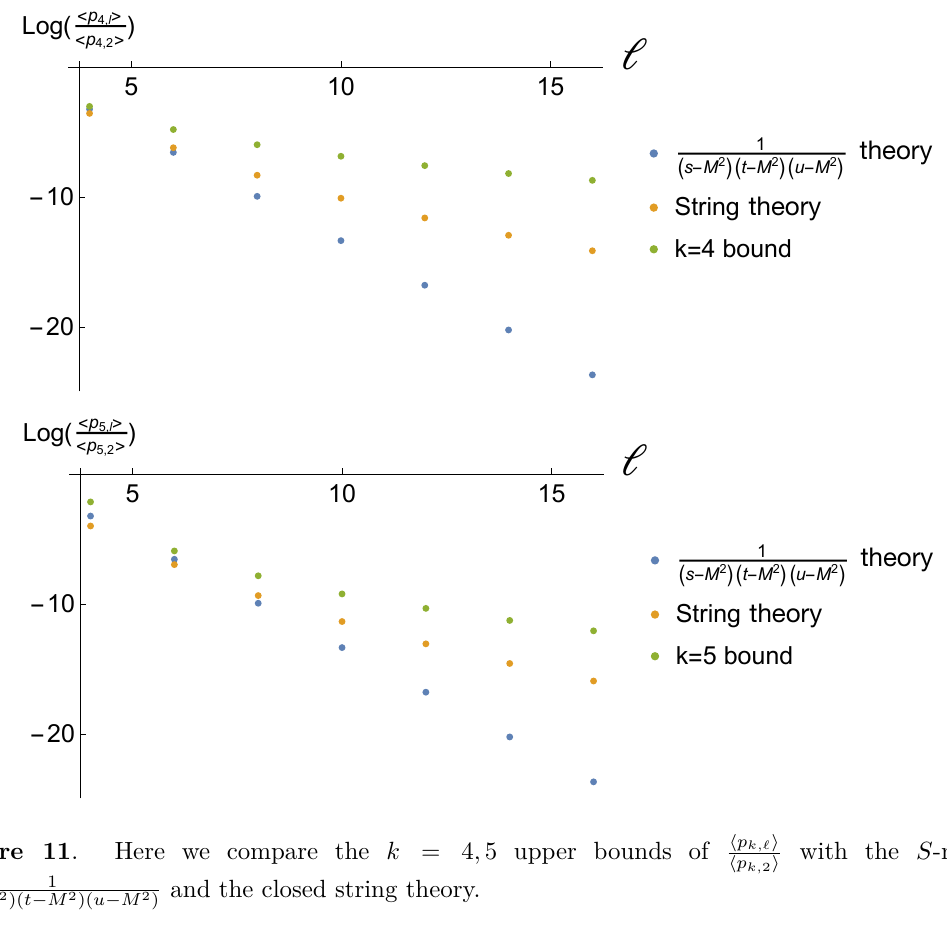
Here we compare the k = 4 , 5 upper bounds of h p k,‘ i and the closed string 1 ( s − M 2 )( t − M 2 )( u − M 2 )